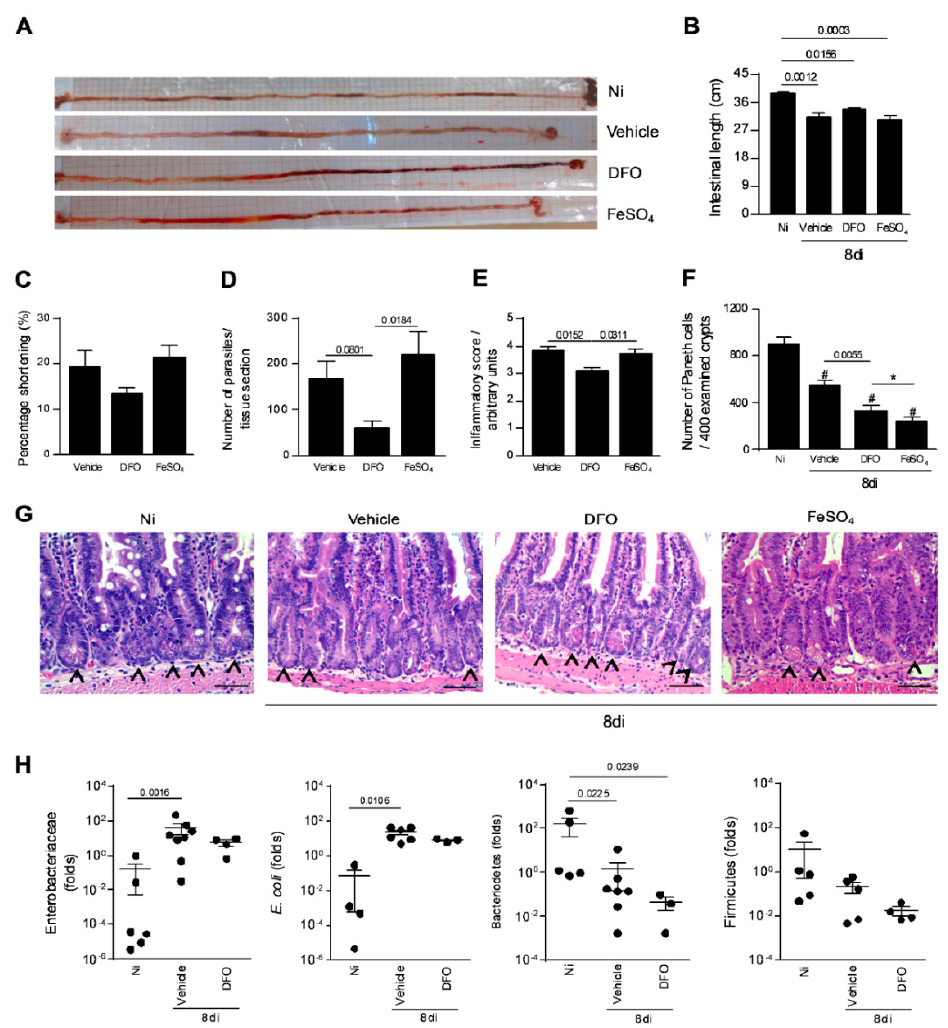
Figure 4. Small intestine parasitism, inflammatory alterations, and relative quantification of some intestinal bacterial population in T. gondii -infected mice treated with an iron chelator or iron supplemented. Gross picture of the small intestine of non-infected (Ni) or infected C57BL / 6 mice with 20 ME-49 T. gondii cysts by oral route and treated with vehicle (PBS) or 300 mg / Kg of deferoxamine (DFO) or 100 mg / Kg of iron sulfate heptahydrate (FeSO 4 ) by intraperitoneal (i.p.) injection one day prior to infection, and for an additional seven days post-infection ( A ). Intestinal length ( B ) and shortening percentage of the small intestine ( C ). Tissue parasitism in the small intestine was detected by immunostaining and quantified by tissue section ( D ). Inflammatory score in the small intestine ( E ). Quantification of Paneth cells in 400 intestinal crypts ( F , G ). Arrows indicate Paneth cells. Relative quantification of intestinal Enterobacteriaceae , E. coli , Bacteriodetes , and Firmicutes by qPCR ( H ). Data were analyzed by one-way analysis of variance (ANOVA) followed by Sidak’s post-test ( E , F ) and Kruskal Wallis followed by Dunn’s post-test (B, D, H). (*)(#) p < 0.0001; (#) differences in relation to non-infected (Ni) mice. Scale bar = 50 µm.